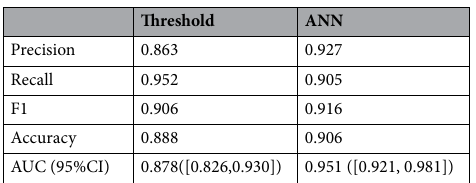
Table 4. Comparison between the threshold and ANN methods.